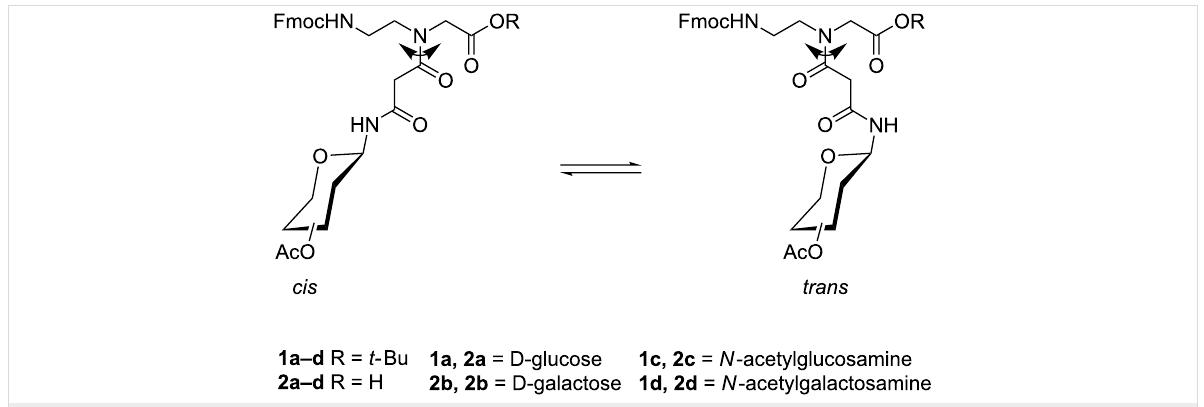
Figure 1: cis - and trans rotamer of protected PNA building blocks 1a–d and 2a–d .